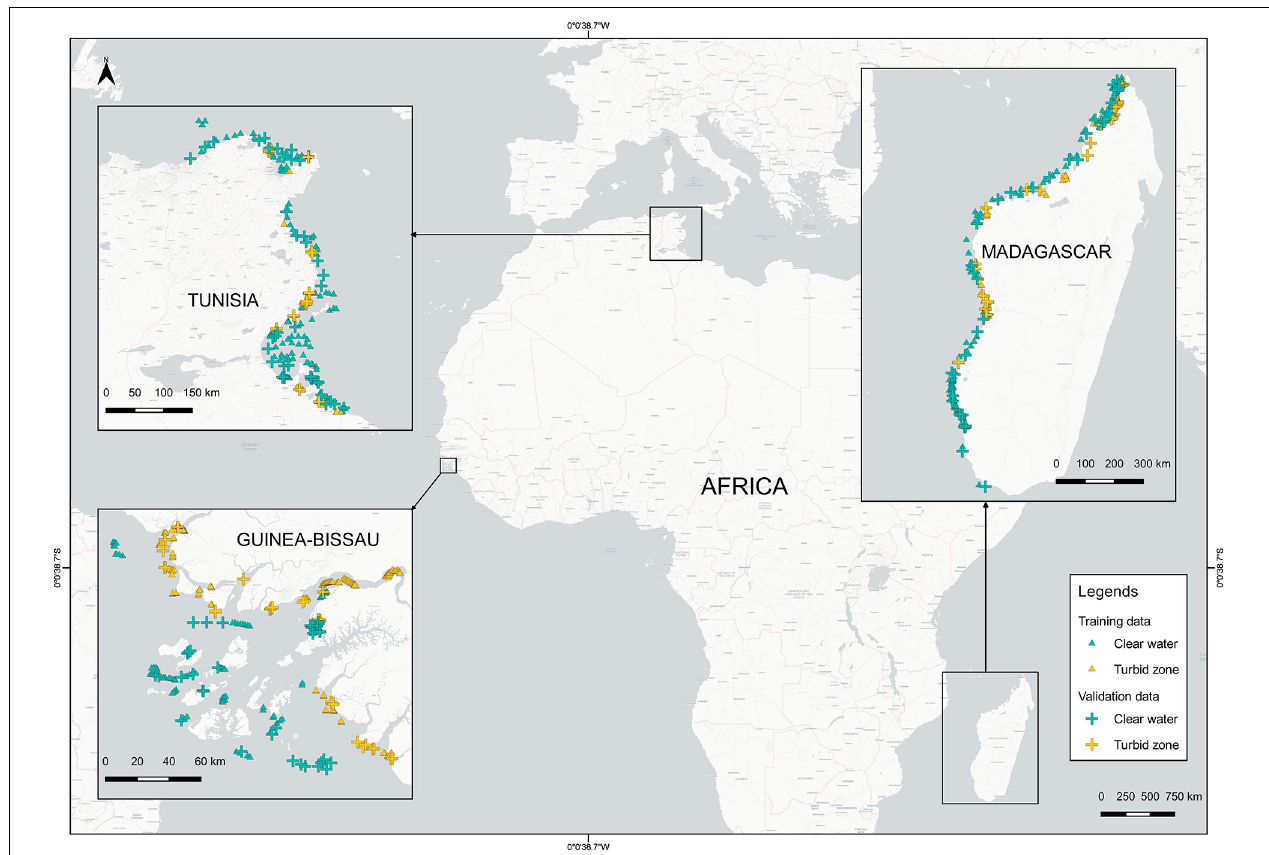
FIGURE 1 | Map of the study regions; Guinea-Bissau, Tunisia, and the west coastline of Madagascar with annotated training and validation data points for CW and TZ (basemap by